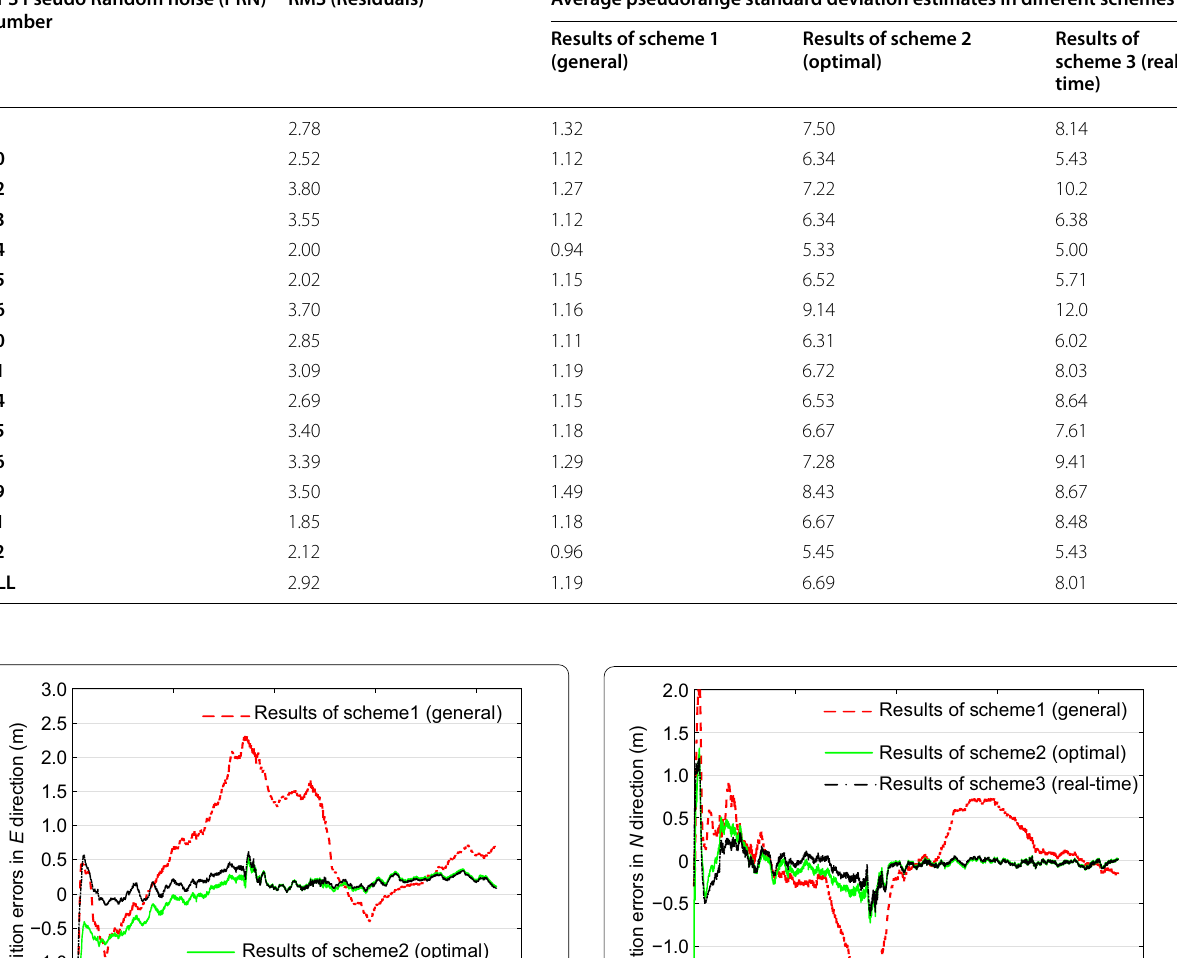
Table 2 Statistical results of the of pseudorange measurement residuals and standard deviation estimates for each satellite GPS Pseudo Random noise (PRN) RMS number